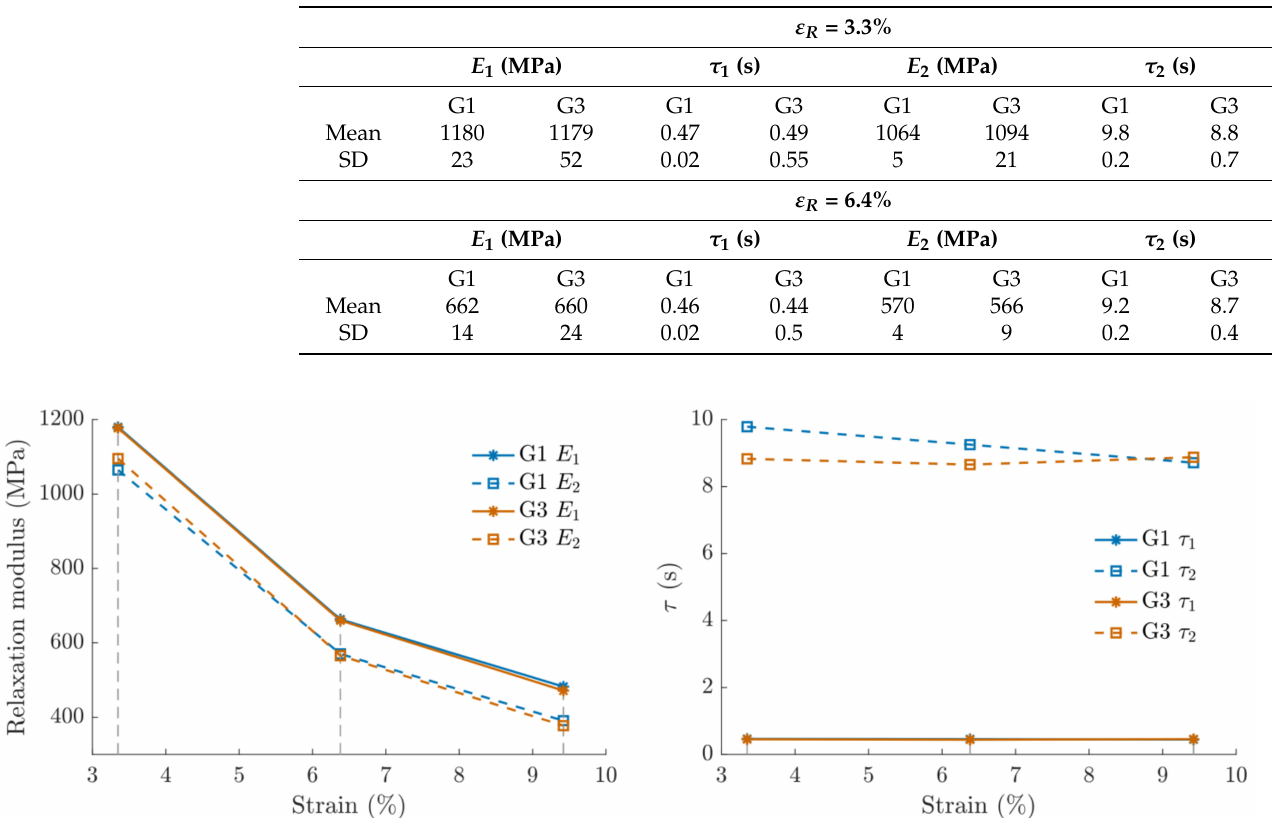
Figure 7. Time–stress curves related to relaxation tests for groups 1 and 3. Table 5. Identified Maxwell parameters for relaxation phenomena.